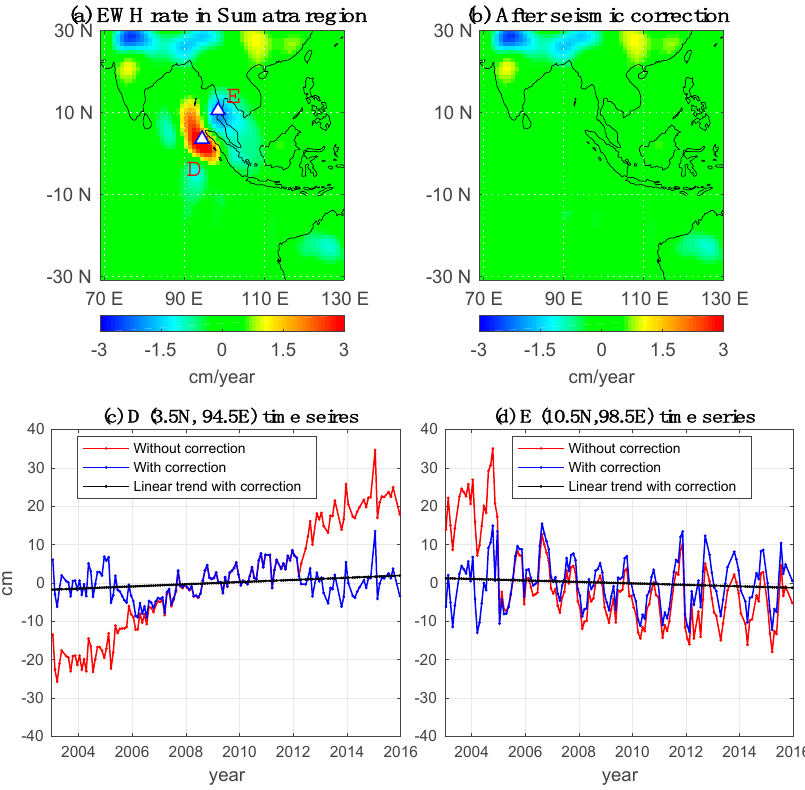
Figure 3. ( a ) The EWH rate distribution in the Sumatra earthquake region, ( b ) the rate distribution after the seismic effect correction, ( c ) the time series at the point D (3.5°N, 94.5°E), and ( d ) the time series at the point E (10.5°N, 98.5°E).